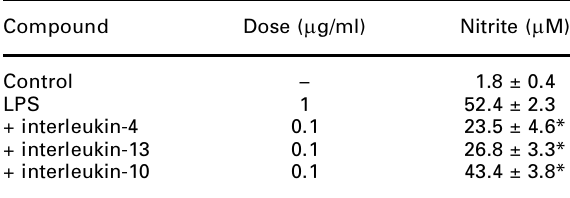
Table 2 . Effect of interleukin-4, interleukin-10 or interleukin- 13 on the increase in the formation of nitrite in supernatant